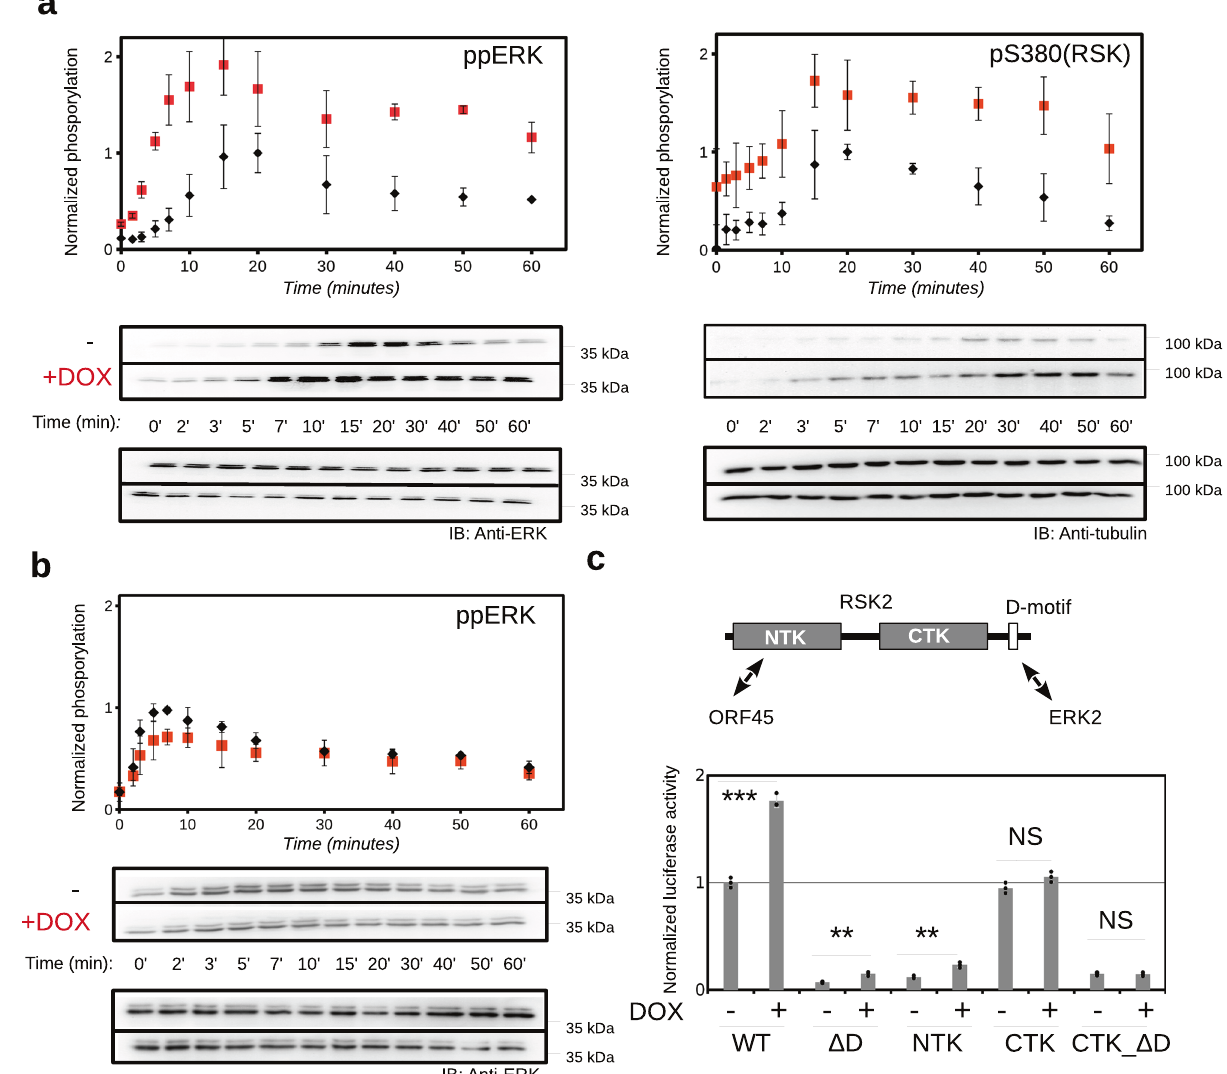
Fig. 1 EGF triggered ERK and RSK activation in the presence of ORF45. HEK293T ( a ) and HEK293T- Δ RSK1/2 ( b ) cells ( ‘ HT-ORF45 ’ ) were treated with 100 ng/mL EGF and ERK (ppERK) and RSK (pS380) phosphorylation was monitored in Western-blots. Doxycycline treatment (DOX) was used to induce ORF45 expression (data for untreated and DOX treated cells are shown in black or red, respectively). Anti-panERK antibody was used as the load control for ppERK, and anti-tubulin antibody for pRSK Western-blots. Anti-phospho Western-blot signals were normalized to the Control signal (-: no DOX treatment) at 20 min for HEK293T cells and to the 7 min Control signal for HEK293T- Δ RSK1/2 cells. Error bars indicate SD of three independent experiments. Data points show the mean ± SD ( N = 3). Western-blot panels show a representative set. c Mapping of RSK2 regions involved in the ORF45 mediated increase of ERK2-RSK2 binding. Different RSK2 constructs and ERK2 were tagged with the two different fragments of the split fi re fl y